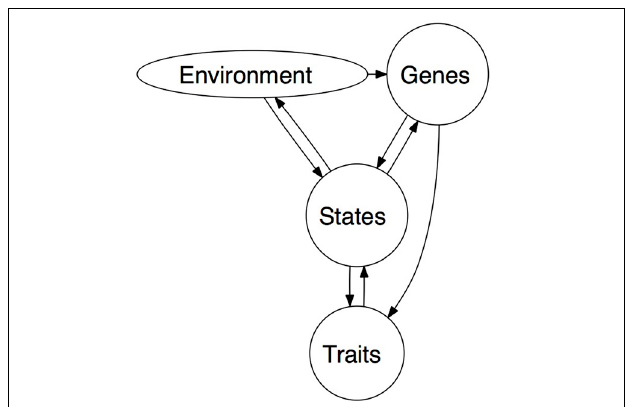
FIGURE 1 | Sociogenomic model of traits (adapted from Roberts and Jackson, 2008).